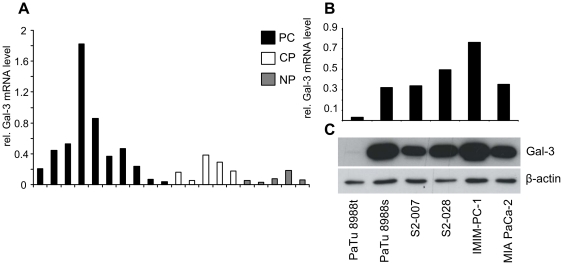
Overexpression of Gal-3 in pancreatic cancer primary tissues and cell lines.Gal-3 mRNA levels were determined by quantitative real-time PCR (qRT-PCR) (A, B). Ribosomal protein, large, P0 (RPLP0) was used as the reference gene. PC: pancreatic cancer ; CP: chronic pancreatitis ; NP: normal pancreas. Protein expression in different pancreatic cancer cell lines was determined by Western blot (C) analyses. β-actin was used as loading control.